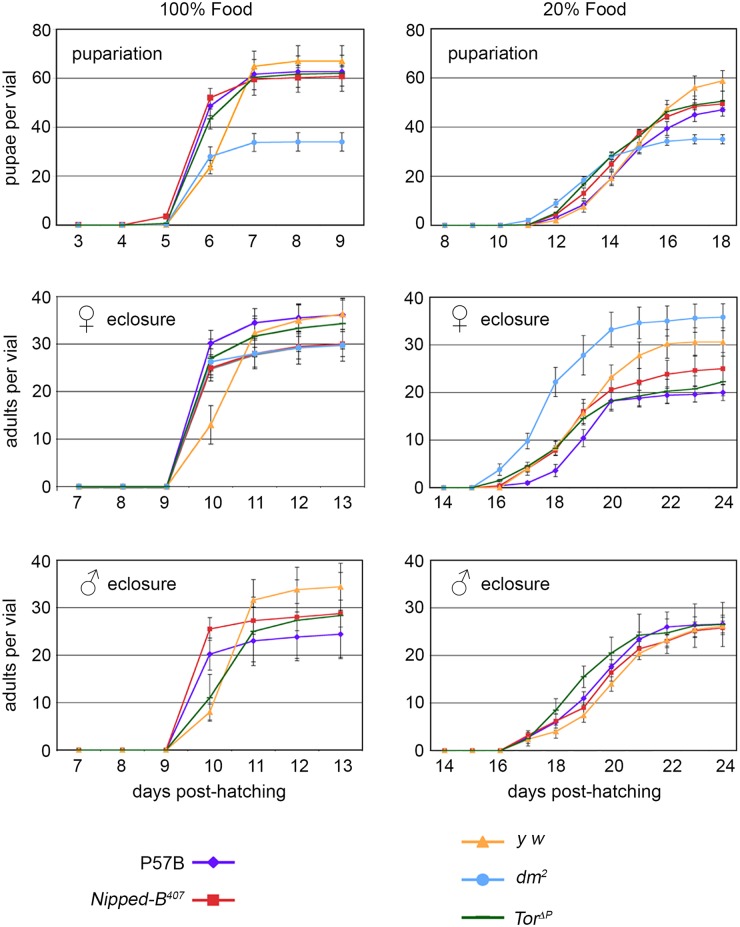
Effects of heterozygous Nipped-B, dm, and Tor mutations on timing of pupariation and eclosion.Newly hatched 1st instar larvae of the indicated genotypes were placed in vials at 100 per vial, containing either normal (100%) or diluted food (20%). The number of pupae and eclosing male and female adults were counted every day for up to 24 days. P57B (P57B/+) is the matched wild-type parental control for Nipped-B
407 (Nipped-B
407
/+). y w (y w/+ females and y w/Y males) were the controls for the dm
2 (dm
2/+ females) and Tor
ΔP (Tor
ΔP/+) mutants. The data shown is from a single experiment and two additional independent repeats with Nipped-B
407 and P57B gave very similar results. Error bars are standard errors.